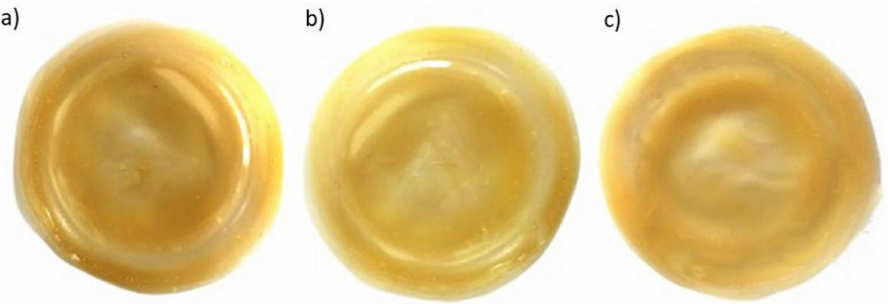
Figure 1. Thermo-responsive scaffold prototypes for DKT controlled release: ( a ) F1; ( b ) F2; ( c )